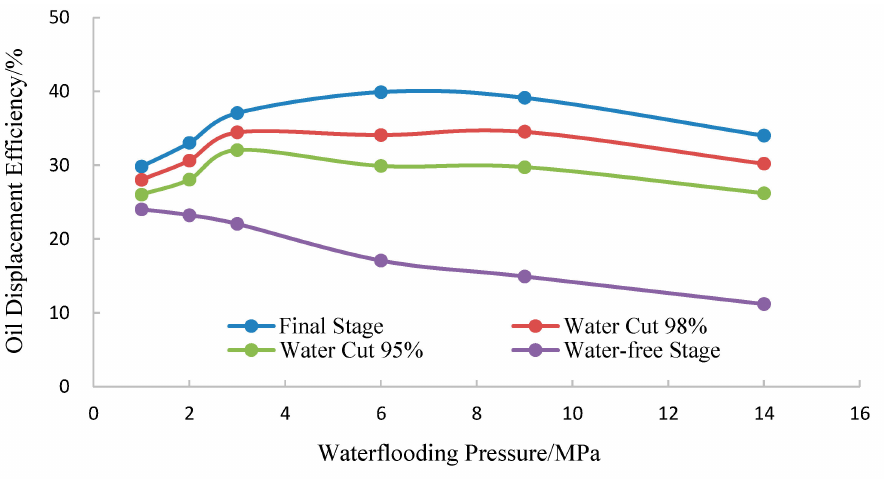
Figure 14. Relation curve of waterflooding pressure and oil displacement efficiency.